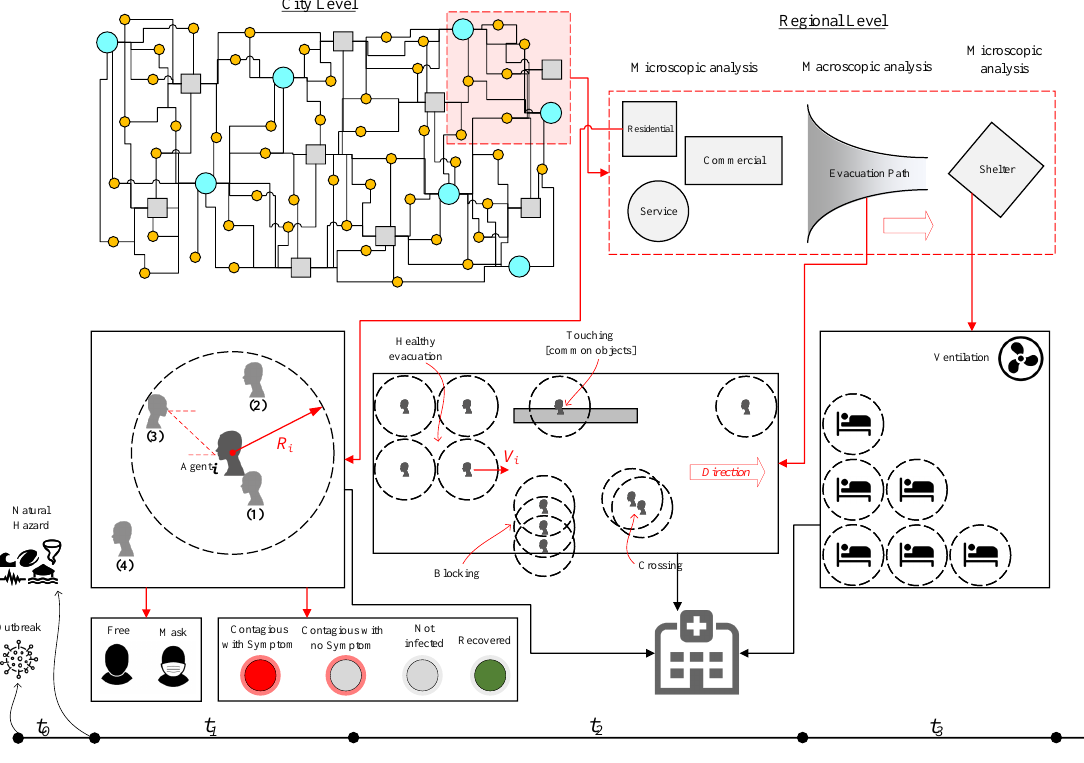
Figure 6. Evacuation and sheltering in pandemic era after a natural hazard; in city level figure ( top left ), the circles and squares present different types of buildings; the timeline axis presents the pandemic era before natural hazard occurrence, t 0 , during staying inside a confined place, t 1 , during evacuation, t 2 , and during sheltering, t 3